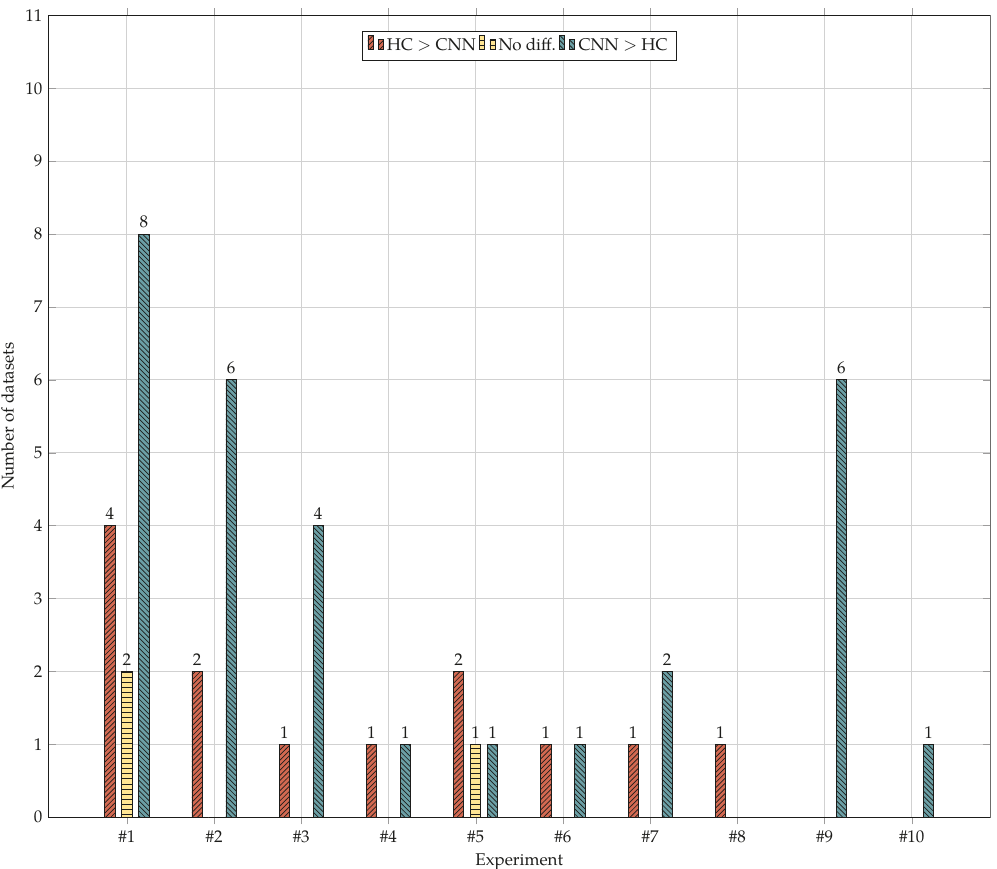
Figure 16. Number of datasets on which: hand-crafted methods performed significantly better than CNNs (“HC > CNN”); there was no significant difference (“No diff.”) and CNNs performed significantly better than hand-crafted methods (“CNN > HC”). see also Tables 6–13. Table 16. Results of Experiment #10: non-stationary textures with multiple variations. Figures report overall accuracy by dataset. Boldface denotes the highest value; underline signals a statistically-significant difference between the best hand-crafted and the best CNN-based descriptor. Descriptors are listed in ascending order of by-experiment rank (best